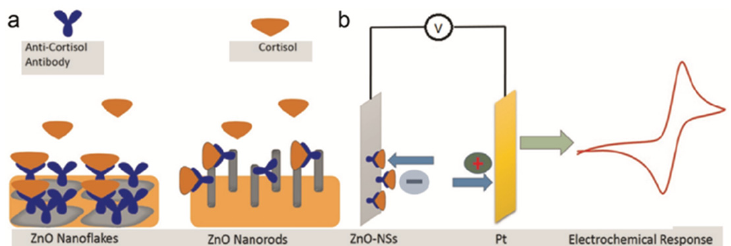
Figure 8. ( a ) The fabrication of the electrochemical immunosensor for the detection of cortisol based on ZnO-NRs and ZnO-NFs, prepared by the sonochemical method and the immobilization of the anti-cortisol monoclonal antibody on ZnO-NSs ( b ) Response obtained by the CV of the fabricated electrodes (reproduced with permission from [63]. Copyright 2015